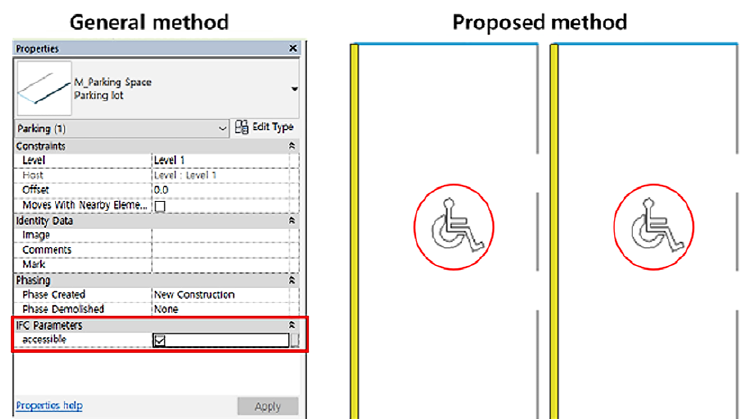
Figure 3. BIM object name recognition process